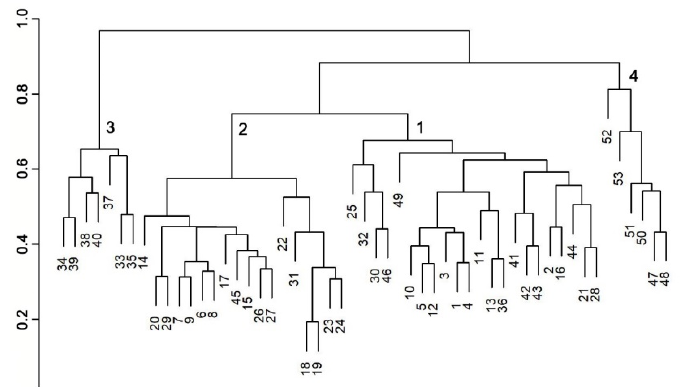
Figure 3. Dendrogram of the field vegetation abundance data matrix of the Mount Conero forests (Marche, Central Italy). Plant associations (Clusters): 1, Cephalanthero longifoliae-Quercetum ilicis ; 2, Cyclamino hederifolii-Quercetum ilicis ; 3, Asparago acutifolii–Ostryetum carpinifoliae ; 4, Pinus halepensis e P. pinea plantation.